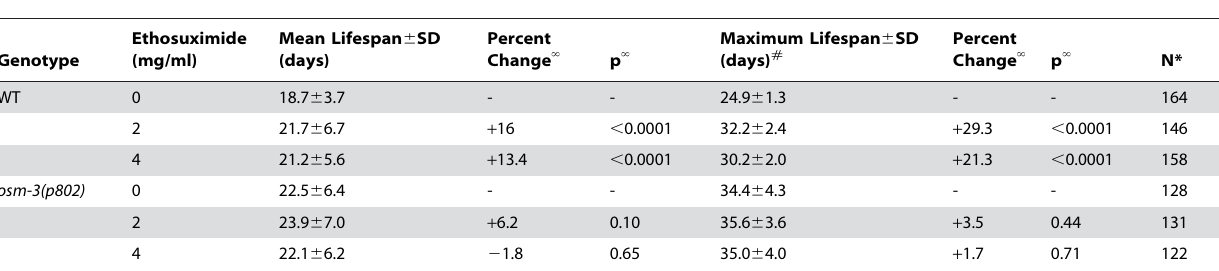
Table 6. osm-3 mutants displayed an extended lifespan and were resistant to the lifespan extension caused by